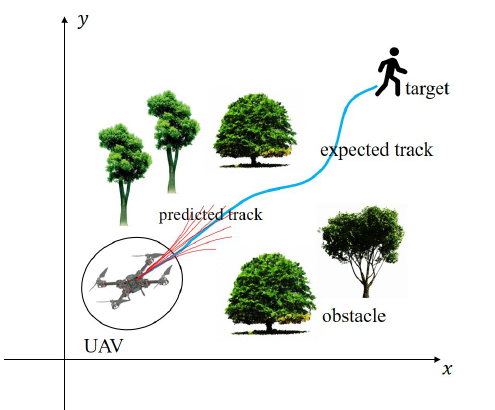
Figure 10. Schematic Diagram of Velocity Sampling and Forward